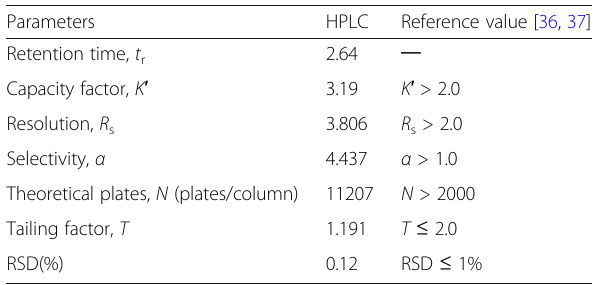
Table 2 System performance parameters obtained by HPLC for tenofovir